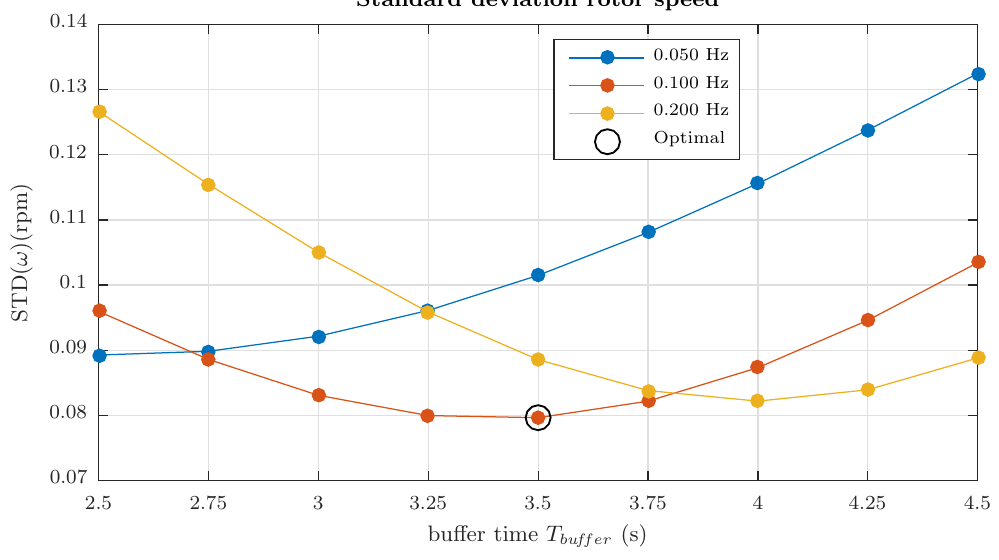
Figure 8. Standard deviation of rotor speed for different buffer times and cutoff frequencies using optimal circularly-scanning continuous wave (CW) lidar